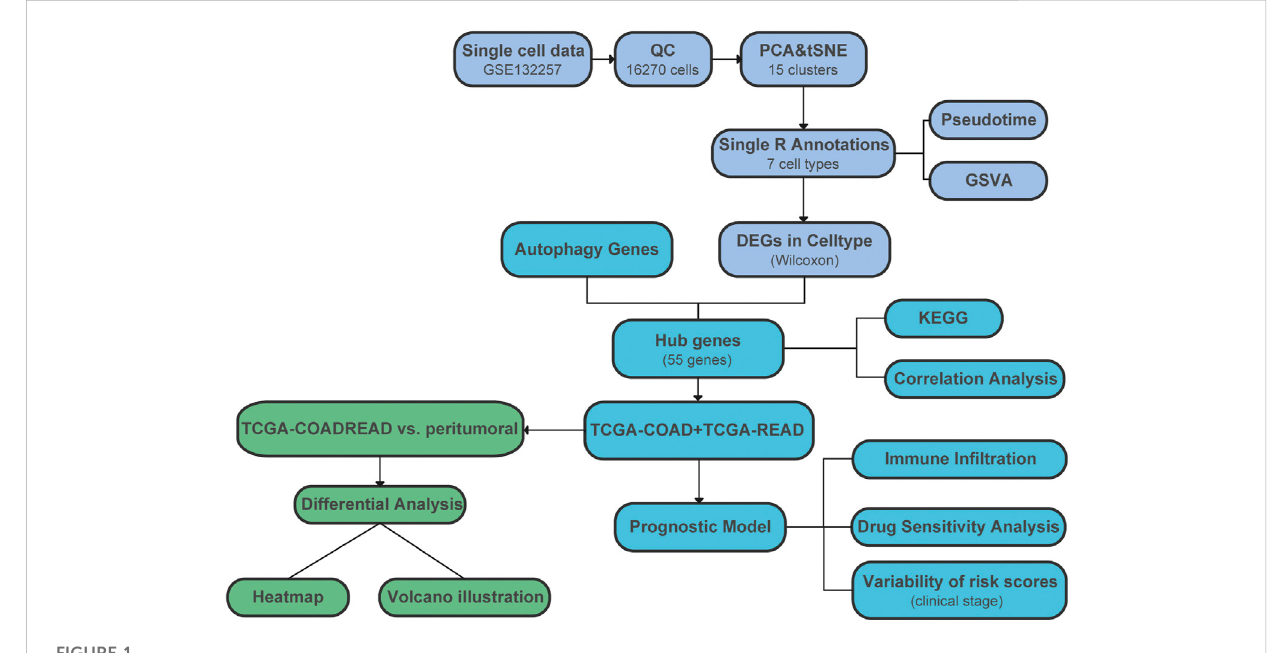
FIGURE 1 Flow chart of analyses performed in this